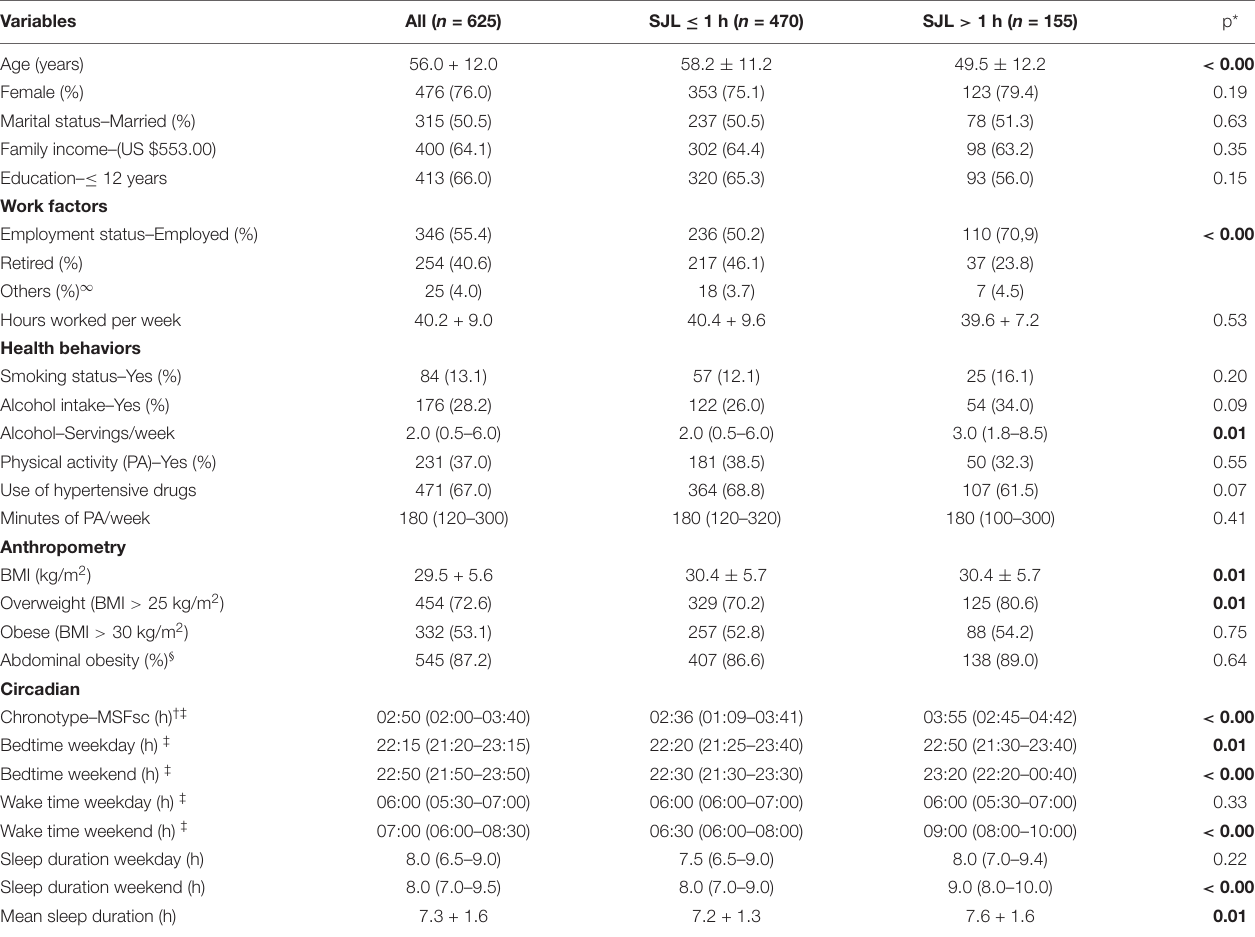
TABLE 1 | Demographic characteristics, work factors, health behaviors, chronic diseases, and anthropometric and circadian variables, according to social jetlag ( n = 625).